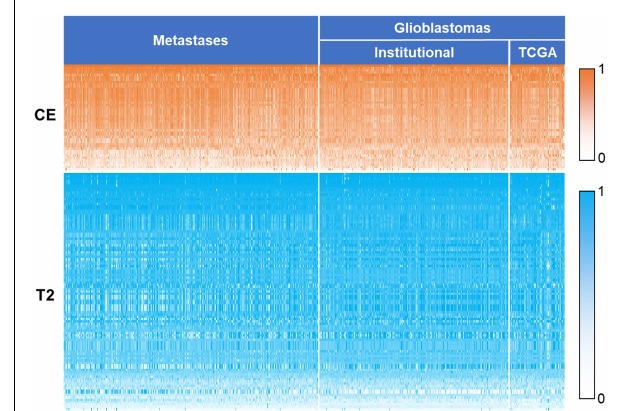
FIGURE 5 | Heatmap of the 149 key features. The values of the features were normalized using min–max normalization. The values of contrast-enhanced T1-weighted features are represented by white to orange (0–1), and values of T2-weighted features are represented by white to blue. CE, contrast-enhanced T1-weighted; TCGA, the cancer genome